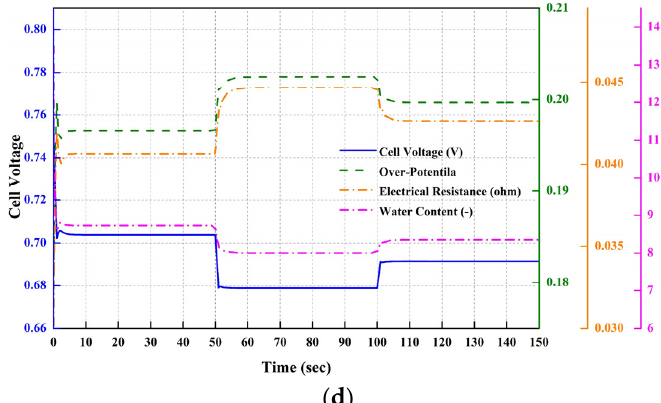
Figure 3. Dynamic responses of fuel cell system (( a ) Thermal management system, ( b ) temperature of stack and coolant, ( c ) heat rejection in stack, ( d ) voltage responses).